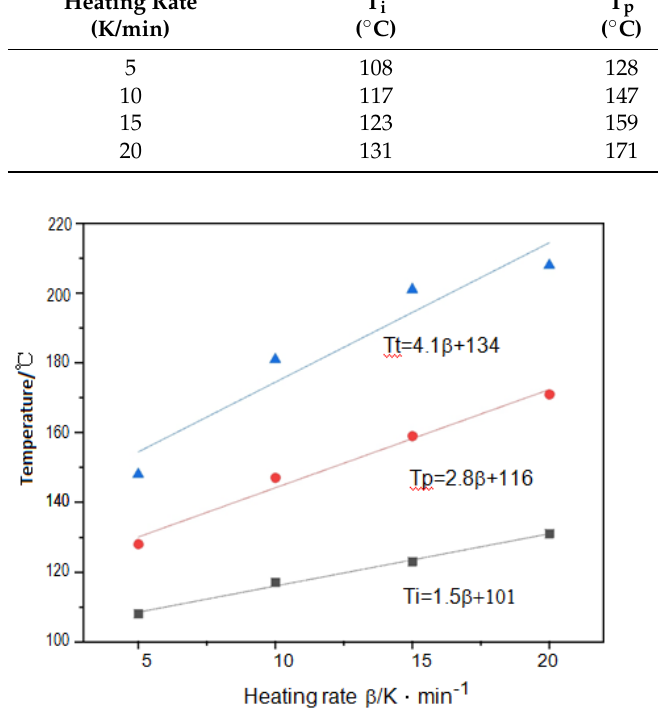
Figure 5. Relationship between β and T i, T p and T t in curing system.